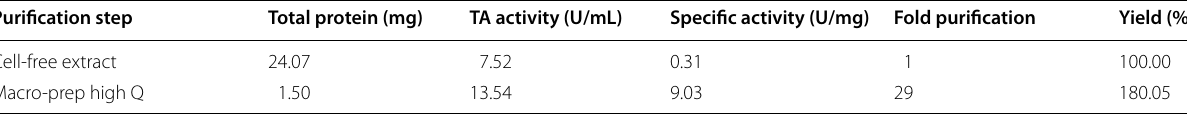
Table 1 Purification scheme of TA from B. licheniformis Purification step Total protein (mg) TA activity (U/mL) Specific activity (U/mg) Fold purification Cell-free